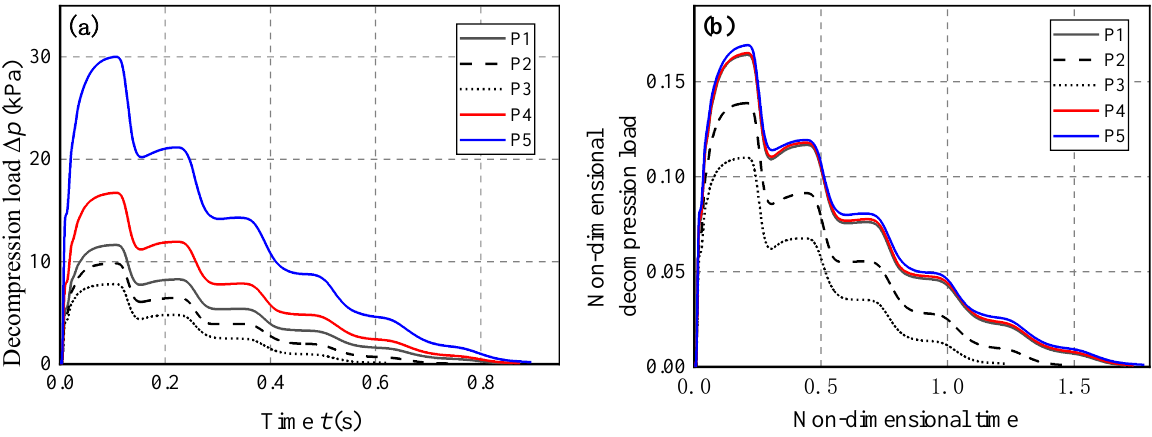
Figure 14. ( a ) Decompression load curves and ( b ) non-dimensional decompression load curves with varying pressure. Table 5. Varying pressure cases.